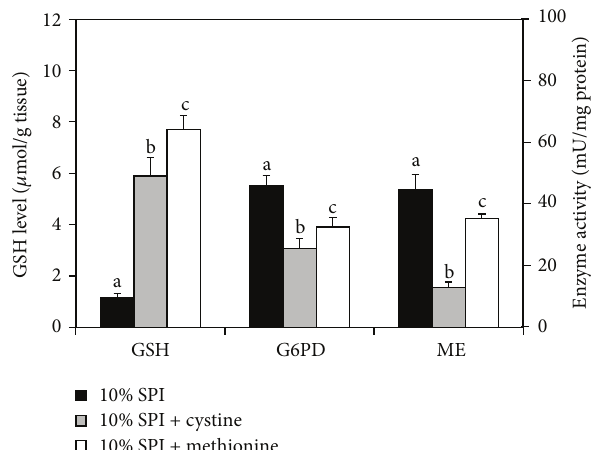
Figure 1: Effects of sulfur-amino acids supplemented to a 10% SPI diet on glutathione concentration and activities of glucose 6-phosphate dehydrogenase (G6PD) and malic enzyme (ME)in rat liver. Values are mean ± SD of 6 rats in each diet group. Different letters show significant difference ( 𝑝 < 0.05 ).